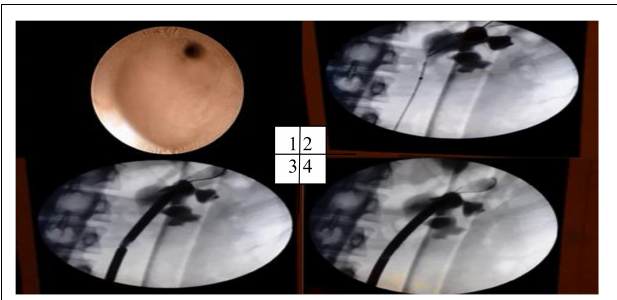
FIGURE 2 | Olbert’s balloon dilatation. Endoscopy view of the stricture from below. (1) Insertion of the Olbert balloon, (2) stricture during, (3) and after dilatation (4).